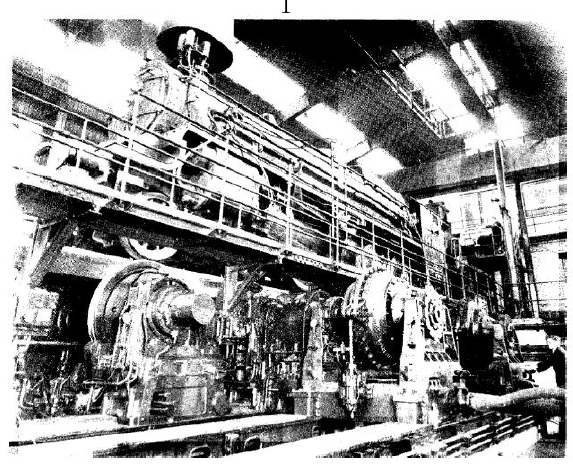
Figure 2. The roller rig in Swindon